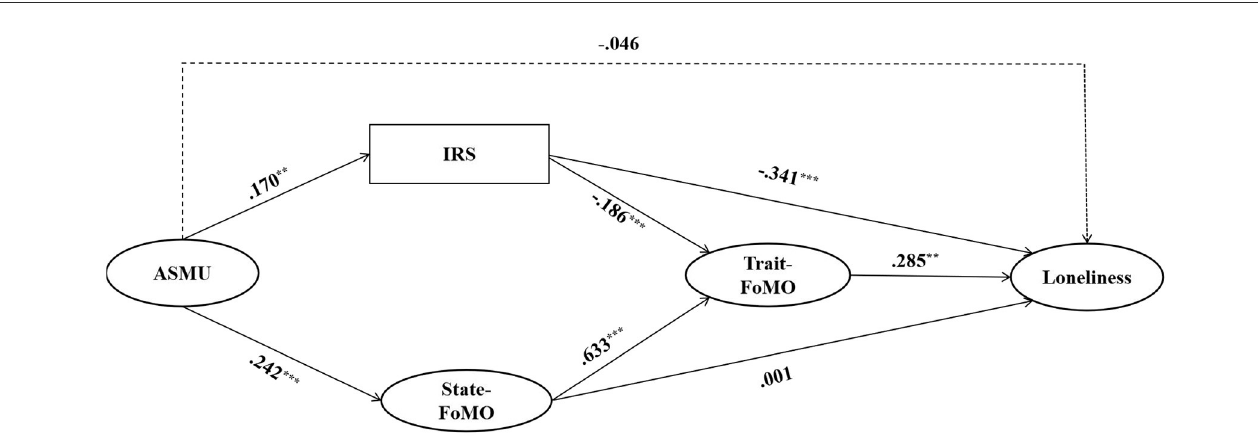
assessment of the quality of their close friends’